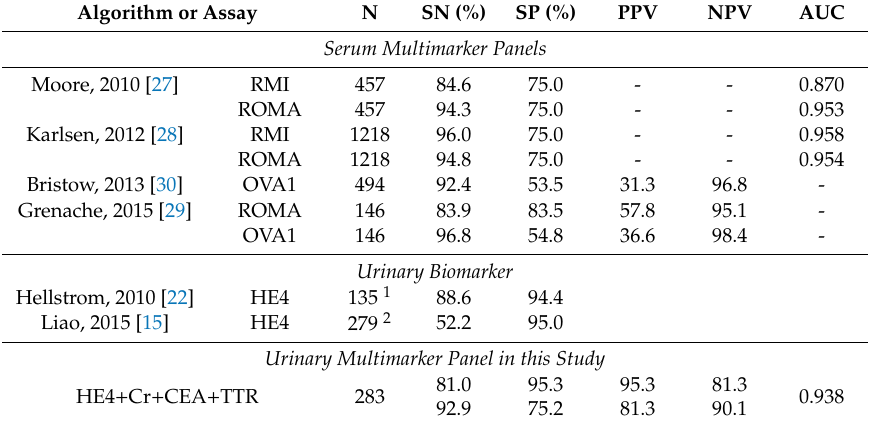
Table 4. Specificity and sensitivity results of various screening strategies in the setting of a pelvic mass. Algorithm or